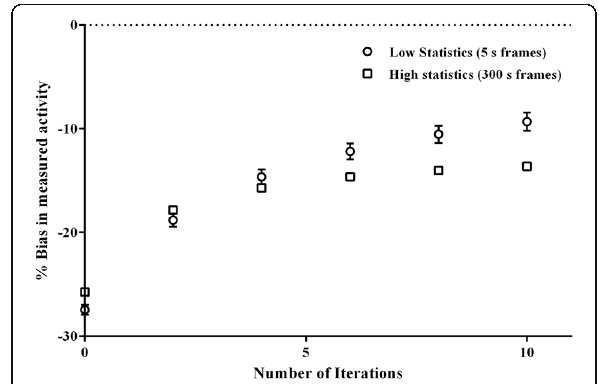
Fig. 1 Effect of number of IDM iterations on bias (mean ± SD of all 5 s frames and 300 s frames) in measured activity concentrations in grey matter regions of the Hoffman